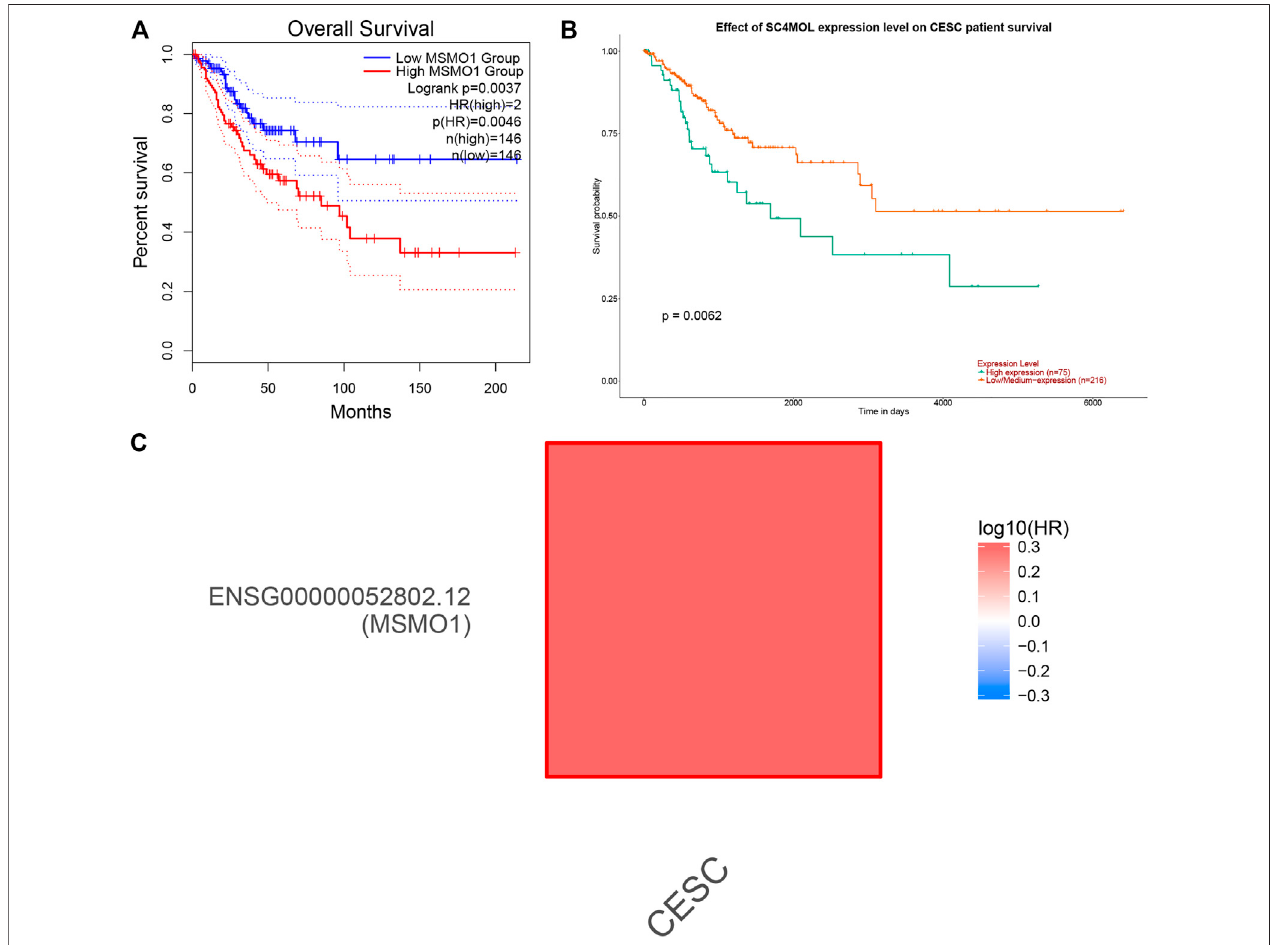
FIGURE 7| The effectof MSMO1 on the survival ofCESC. (A) KM curveof MSMO1 gene in CESC in GEPIA2 database. (B) KM curve ofMSMO1 gene in CESC in UALCAN database. (C) The risk degree map of MSMO1 gene in CESC in GEPIA2.